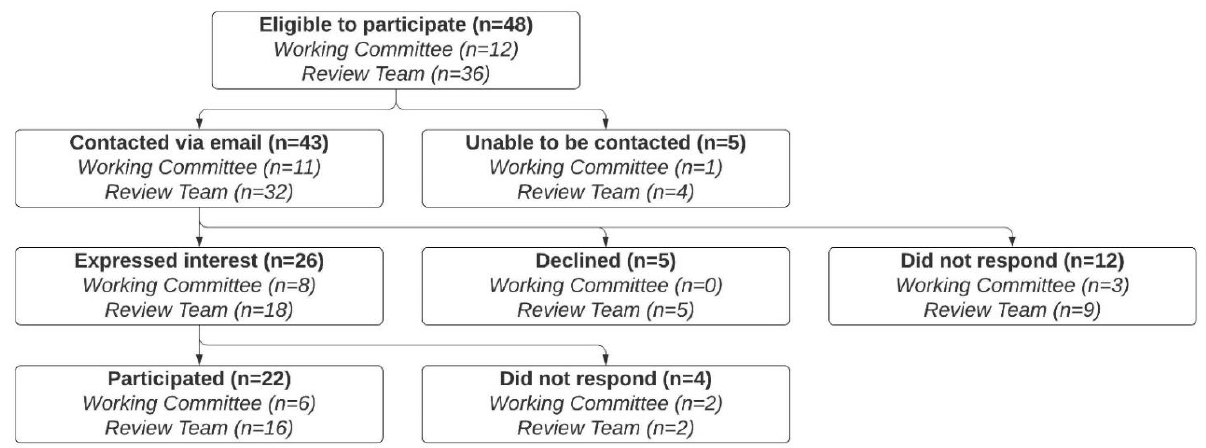
Figure 1. Recruitment and participant characteristics .